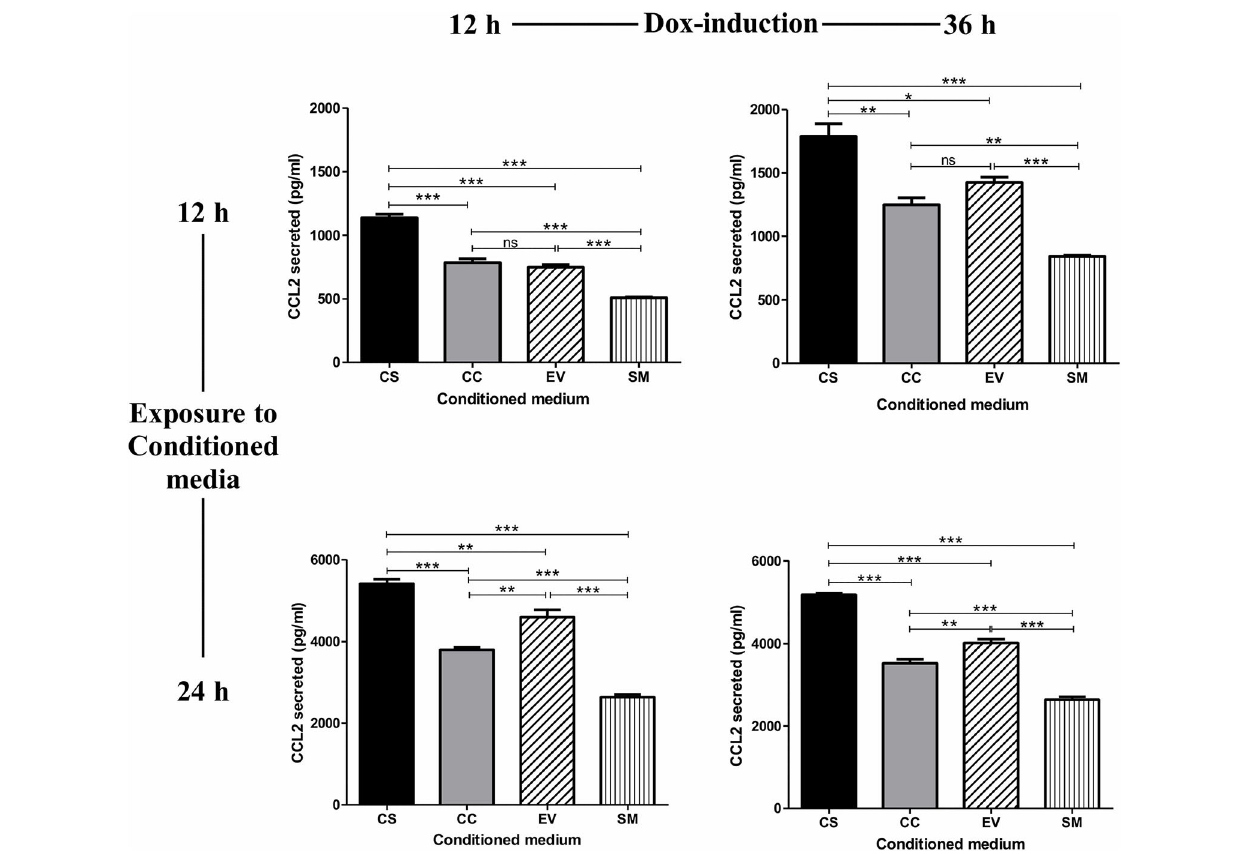
FIGURE 2 | Conditioned medium of CS-Tat Jurkat cells augments CCL2 secretion from HUVEC. The cell-free conditioned media from the Jurkat cells (CS-Tat or CC-Tat or EV) were collected following 12 (left panel) or 36h (right panel) of Dox induction. The conditioned media were added to HUVEC monolayers, and CCL2 secretion from the HUVEC was determined after 12 (top panel) or 24h (bottom panel) of exposure to the conditioned media. The SM (HUVEC treated with RPMI supplemented with 10% FBS) served as the control for background CCL2 expression in the assay. The CCL2 levels were evaluated using an antigen-capture ELISA. EV, empty vector control; SM, serum medium control. The data are representative of three independent experiments. One-way ANOVA with Tukey–Kramer post-test (* p < 0.05, ** p < 0.01, and *** p < 0.001).